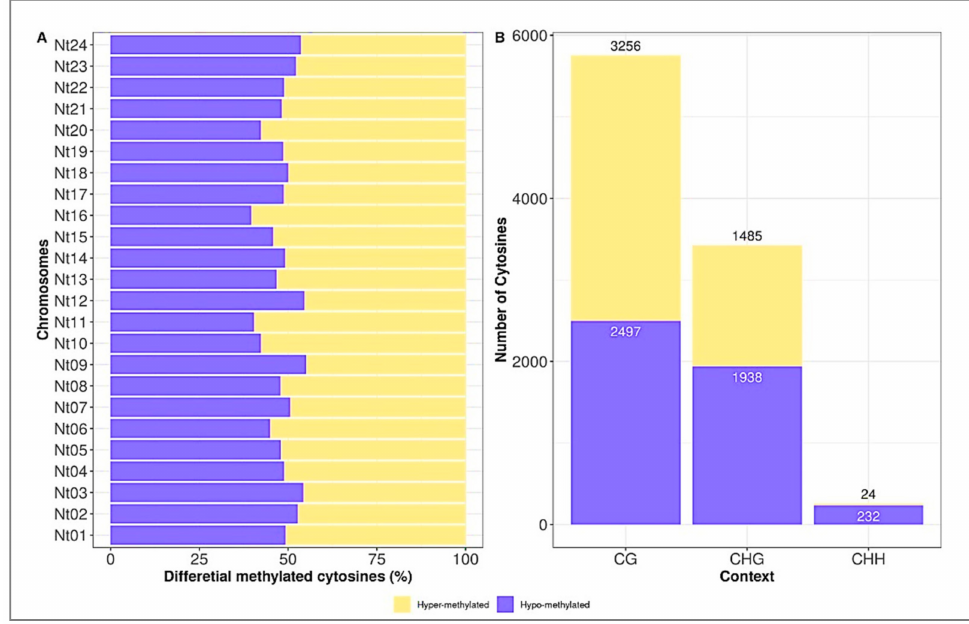
Figure 3. Distribution of relative DmC levels for each chromosome ( A ) and CG, CHG and CHH context ( B ) in the high H 2 O 2 producer transgenic